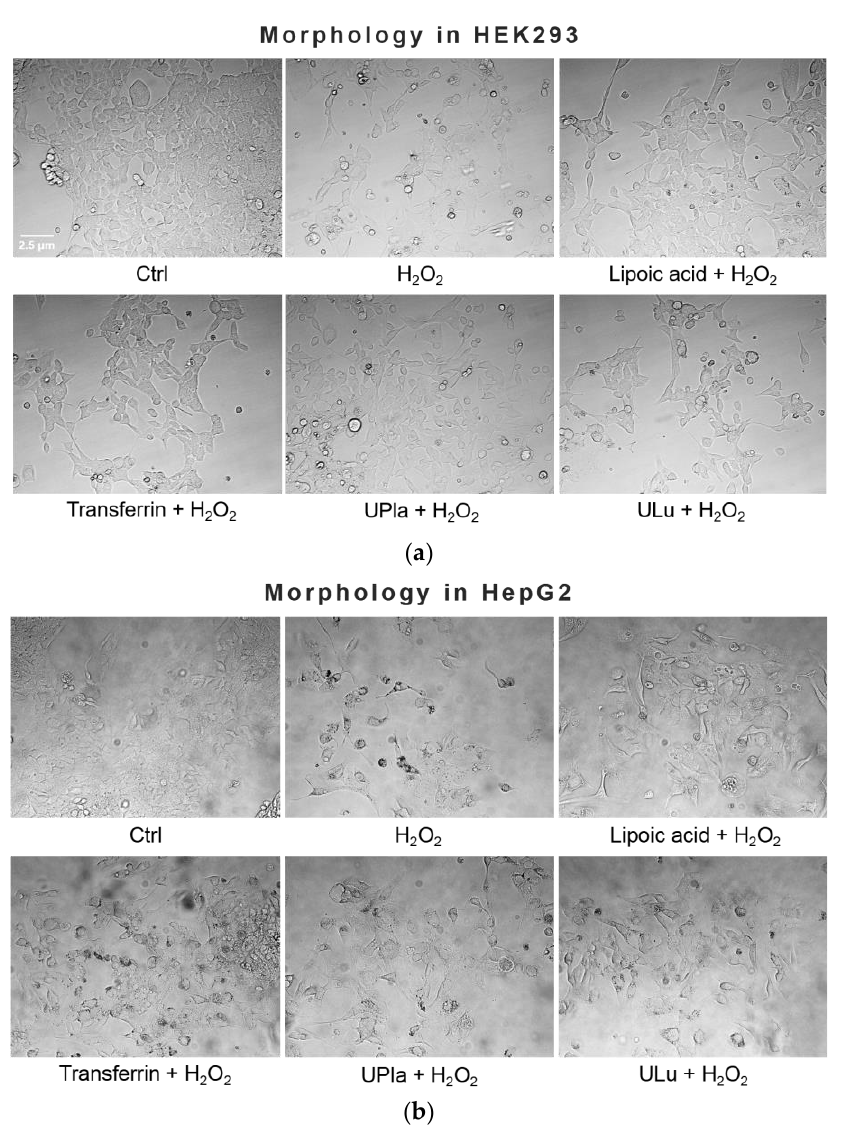
Figure 3. Effect of single substances on H 2 O 2 -induced cell morphology in HEK293 ( a ) and HepG2 cells ( b ). Normal cells were treated with H 2 O 2 (300 μM) with or without single substances for three days, followed by four days of recovery culture. Afterwards, photos of the cells were taken at the magnification of 400× with a light microscope. The results represent three independent experiments.